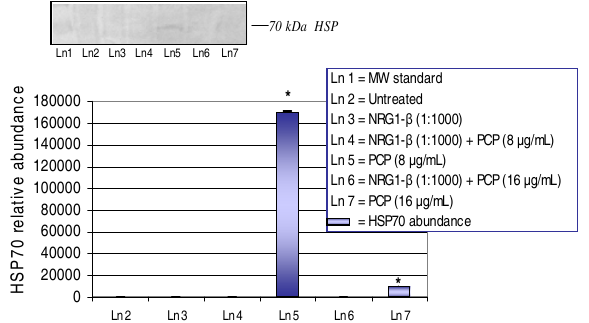
Figure 4: Expression and relative abundance of the 70 kDa heat shock (HSP70) in AML 12 mouse hepatocytes exposed to PCP and NRG1- β + PCP for 48 h. AML 12 mouse hepatocytes were treated with 8 µg/mL and 16 µg/mL concomitant treatments of PCP and NRG1- β +PCP. HSP70 protein identification was assessed following exposure incubation period of 48 h. Inset shows a representative Western blot analysis. Each point represents a mean value and standard deviation of three experiments. *Significantly different ( p<0.05 ) from untreated (0 µg/mL PCP) and NRG1- β (1:1000) treated cells.